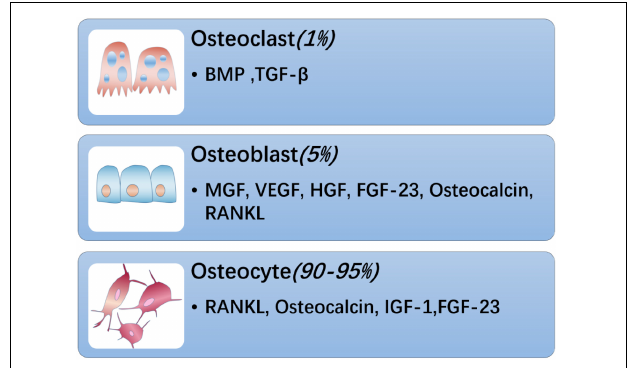
FIGURE 1 | Bone is composed of osteoblasts, osteoclasts and osteocytes. Among them, osteoclasts account for about 1%, which can secrete BMP, TGF- β and other substances; osteoblasts account for 5%, secrete bone-derived factors such as MGF, VEGF, HGF, FGF-23, RANKL, and osteocalcin, and osteocytes account for the largest proportion, About 90–95%, can secrete FGF-23, RANKL, IGF-1, osteocalcin, etc.